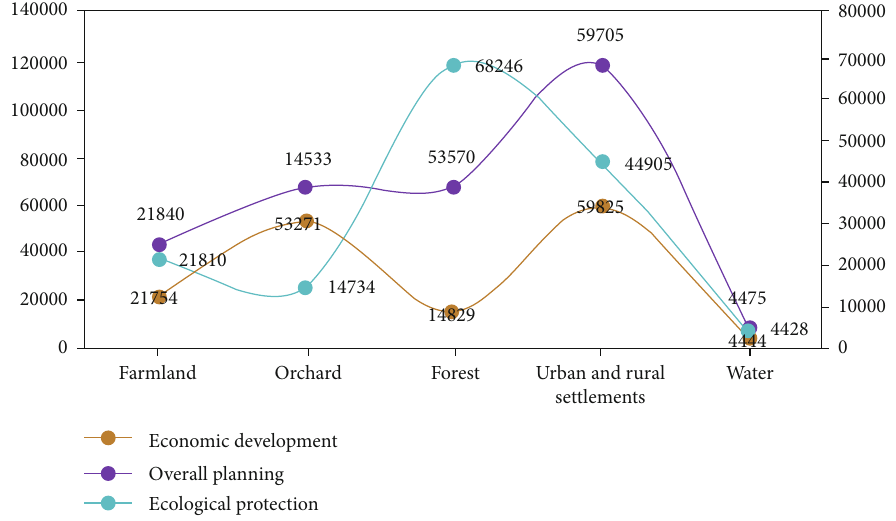
Figure 8: Results of the spatial optimization model for PSO landscape pattern in 2034 for each